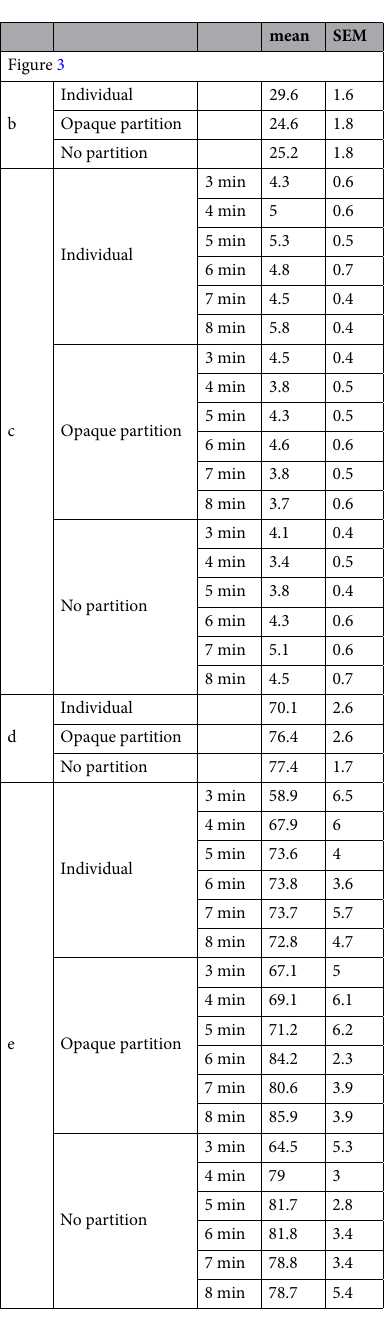
Table 2. Mean and SEM for Fig.